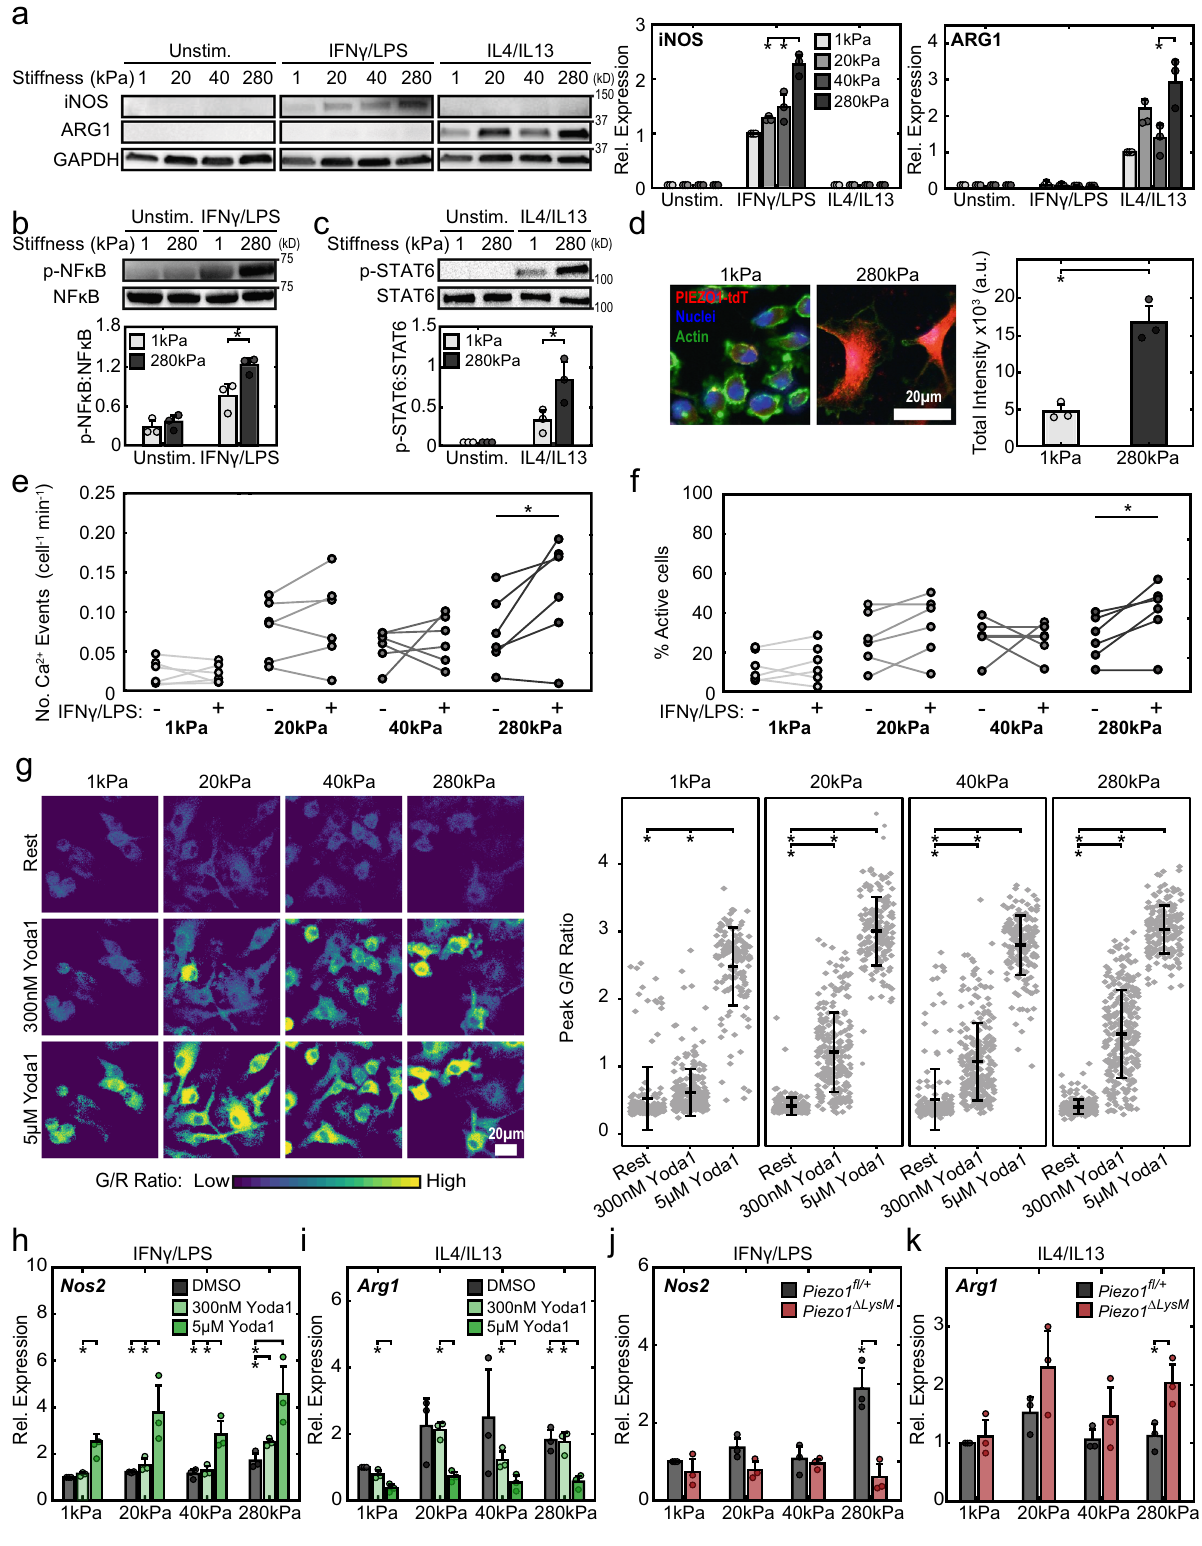
larger Ca 2 + responses to Yoda1 (300 nM) (Fig. 3g). These differences were not observed at higher doses of Yoda1 (5 µM), likely due to a maximum global increase in cytosolic Ca 2 + that obscures the differences in Piezo1 expression across different stiffnesses. Nonetheless, these results suggest that substrate